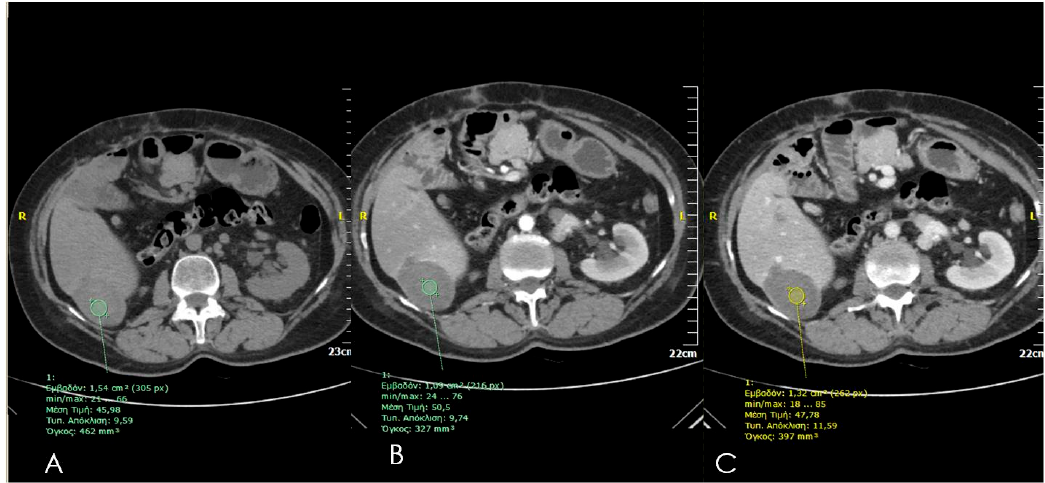
Figure 3. Computed Tomography axial scan prior (A) and post IV injection of contrast medium in arterial and (B) and portal venous phase; (C) one month post ablation illustrating a lack of contrast enhancement within the ablation zone.